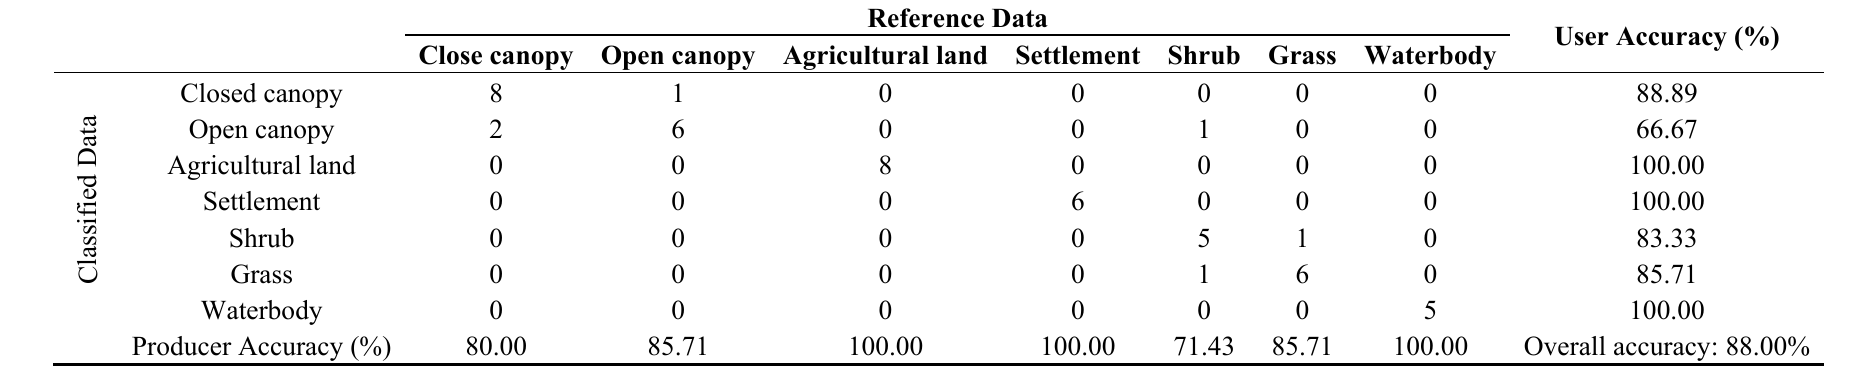
Table S2. Confusion matrix of land use map of Pingzhang village,